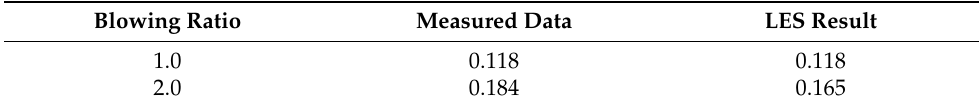
Table 2. Comparison of area averaged film cooling